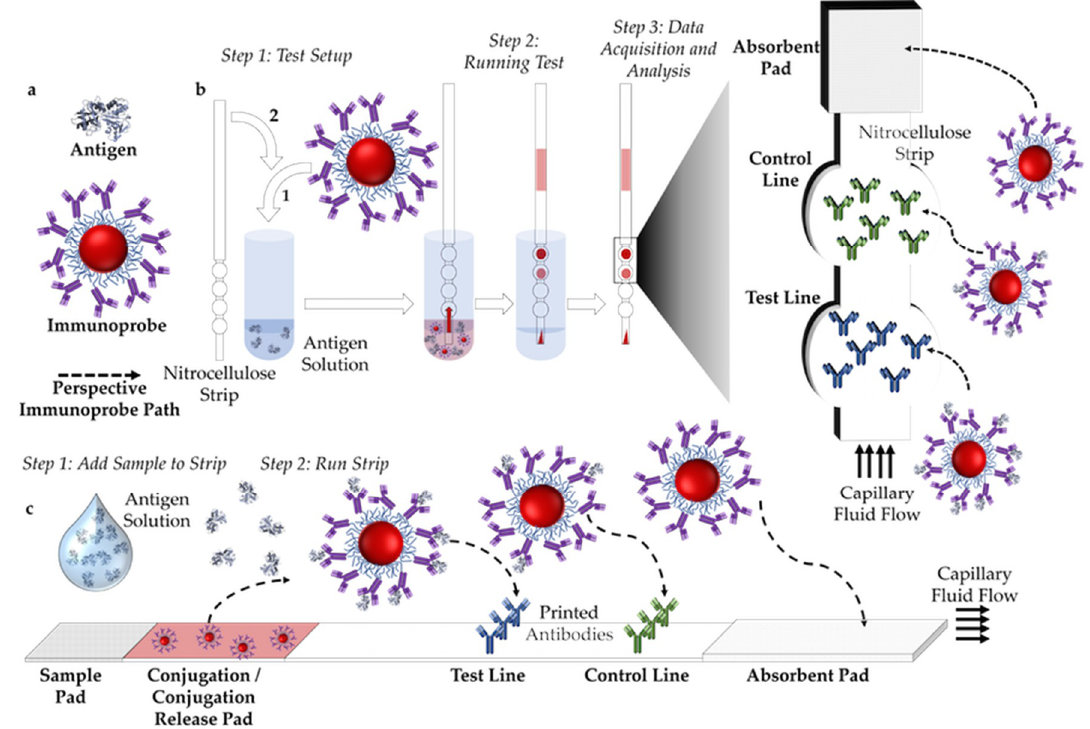
Figure 2. ( a ) Figure legend. ( b ) Schematic representation of a test run and result readout of a dipstick assay configuration. ( c ) Schematic representation of a test run and result readout of a lateral flow assay (LFA)